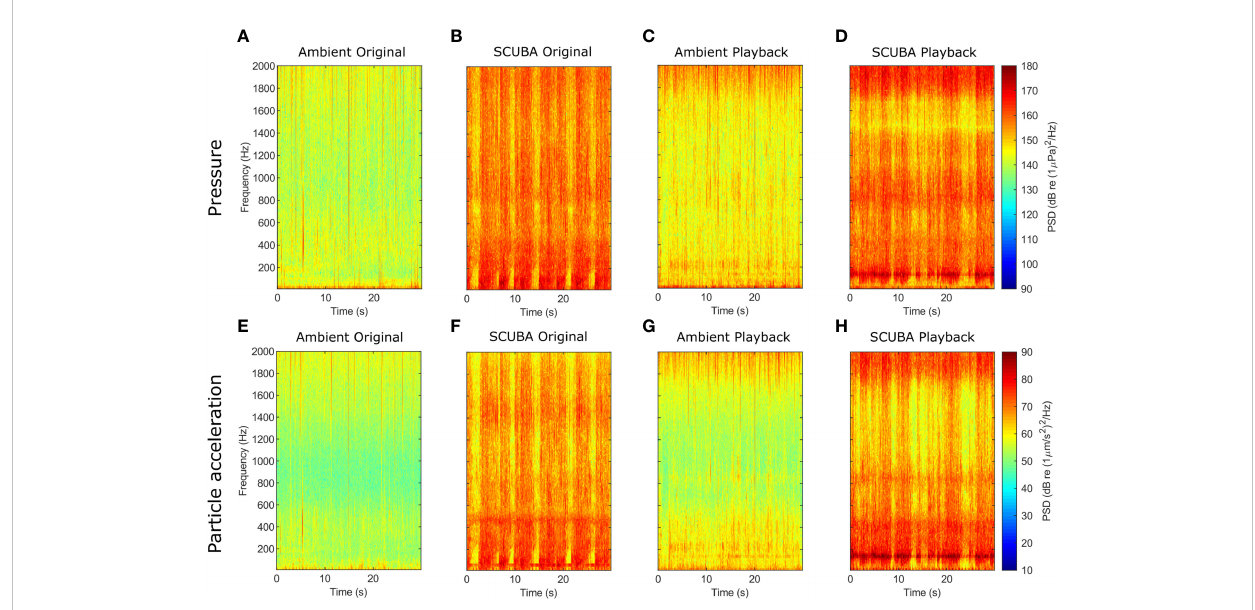
FIGURE 1 Spectrograms of sound-pressure (A – D) and triaxial particle-acceleration levels (E – H) for original ambient-sound (A, E) and SCUBA-noise (B, F) recordings, and playback tracks for ambient-sound (C, G) and SCUBA-noise (D, H) treatments. For these comparisons, 30-s subsamples of one SCUBA-diving pair and one ambient recording were analysed (fft window length = 4048, Hamming fi lter, 75% overlap, 0 – 2